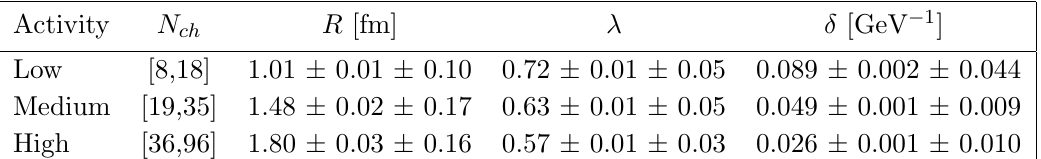
Table 2 . Results of (cid:12)ts to the double ratio r d ( Q ) for the three di(cid:11)erent activity classes and corre- sponding N ch bins, using the parameterisation of eq. (2.3). Statistical and systematic uncertainties are given